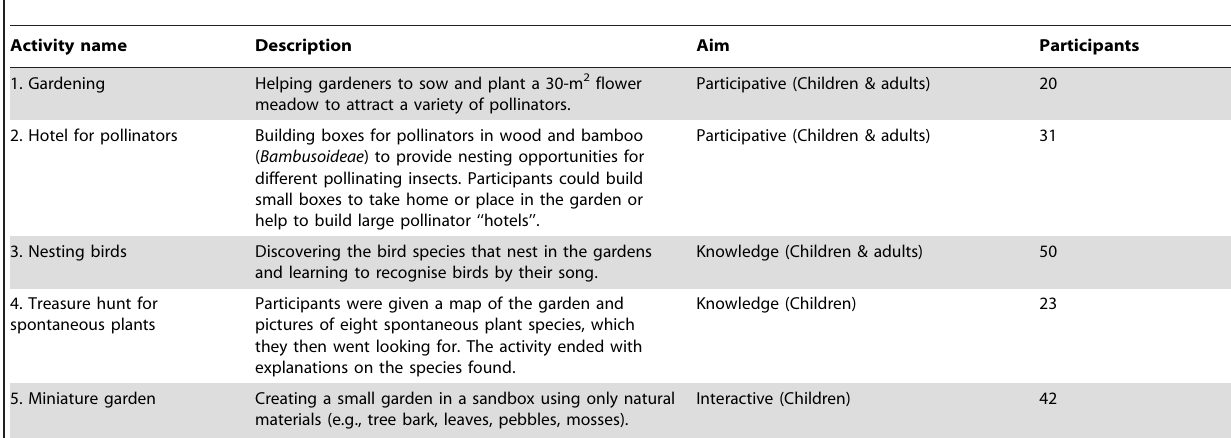
Table 1. Description of the five activities proposed to the participants during the three activity days.